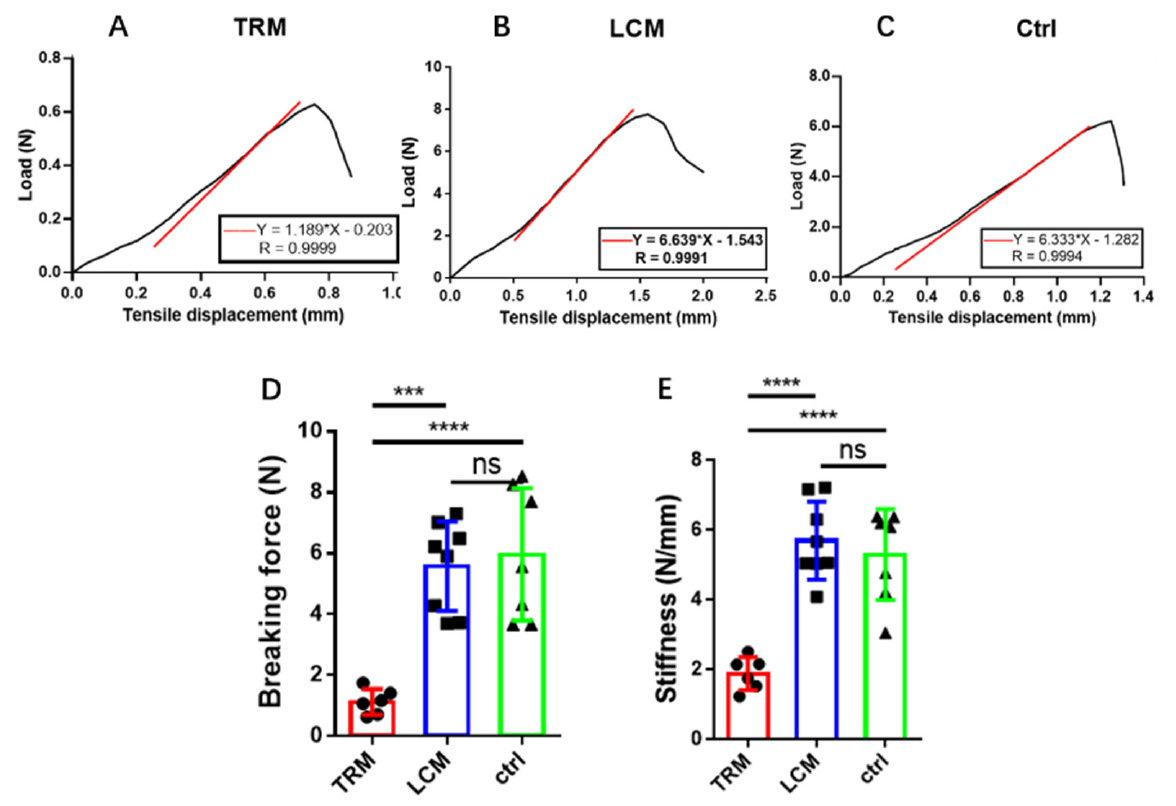
Figure 5. Biomechanics of the three groups. ( A – C ) Representative force-displacement curve. Break- ing force and stiffness were recorded by the testing system automatically. The diagrams were copied from the testing system by the Engauge Digitizer and Prism, software. Red lines show the slope of the linear region of the documented curve. ( D ) Breaking force. ( E ) Stiffness. Mean ± SD, *** p < 0.001; **** p < 0.0001; ns, no significance.